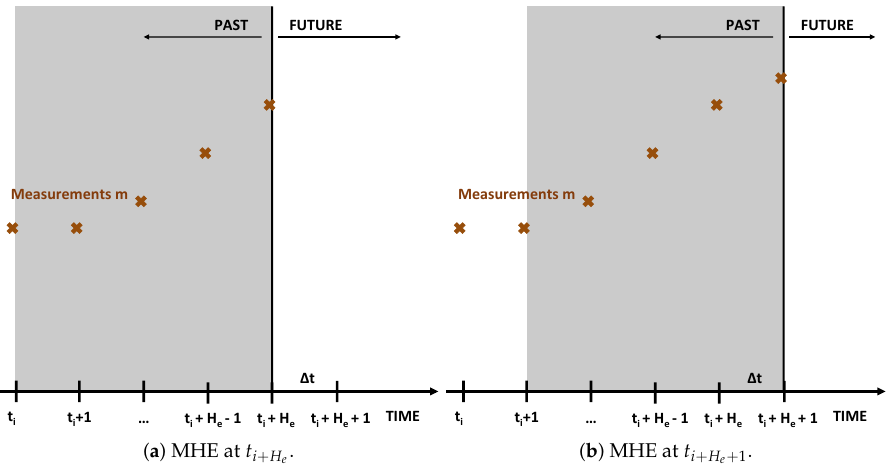
Figure 1. Illustration of two consecutive MHE